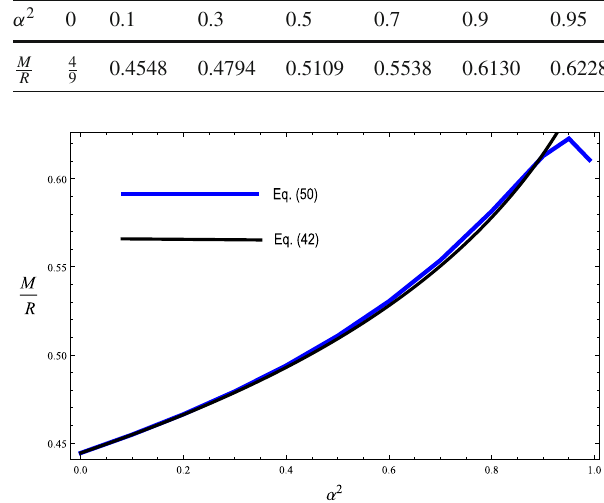
Fig. 8 Compactness ratio M